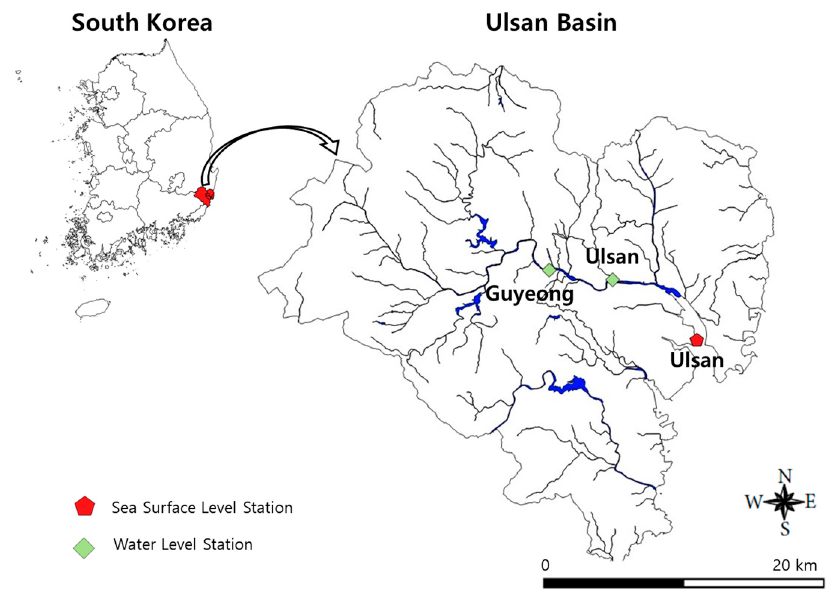
Figure 3. Stream water level and sea surface level stations in Ulsan.